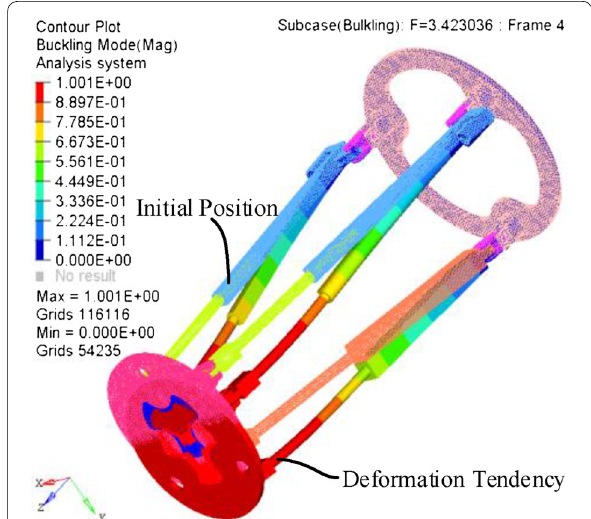
Figure 11 Result of the buckling analysis of the mechanism (mm)